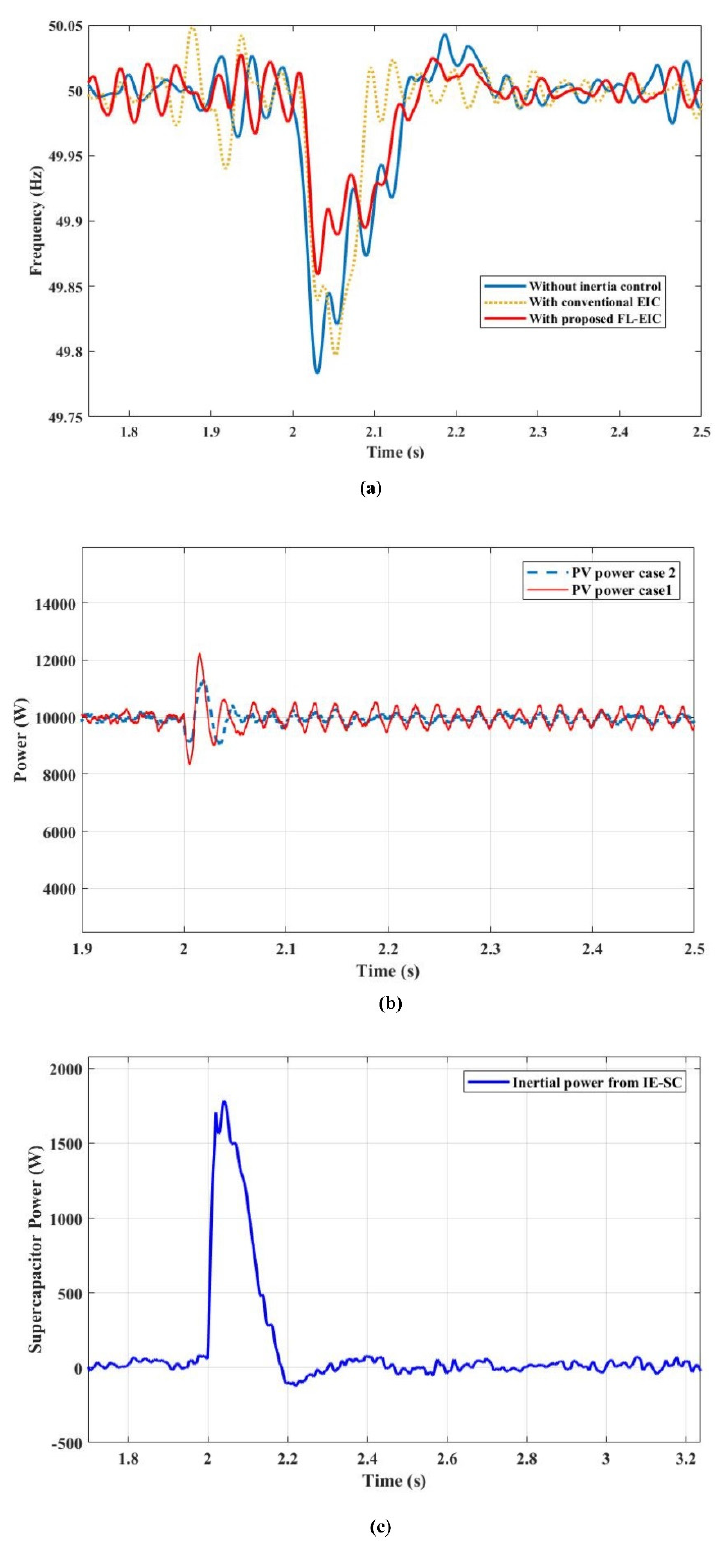
Figure 11. Under-frequency event ( a ) Frequency, ( b ) Power from PV, ( c ) Supercapacitor power.